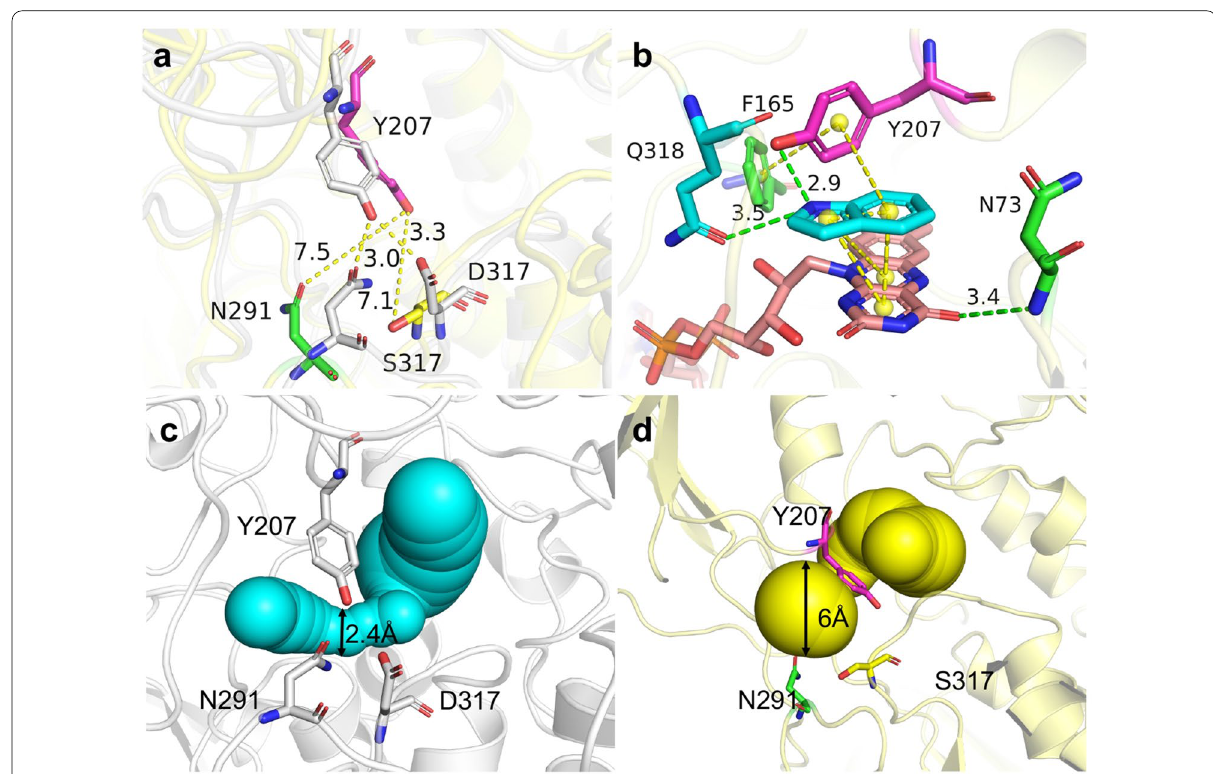
Fig. 8 Structure of K223R/D317S mutant. a Comparison of the distance of residue 207–291 and residue 207–317 in wild‑type bFMO (grey) and the K223R/D317S mutant (yellow), respectively. Residues are shown as gray sticks in wild‑type bFMO. However, the residue 207, 291 and 317 are shown as purple, green and yellow sticks in the K223R/D317S mutant, respectively. b π–π interaction of Y207 (purple), indole (blue) and FAD (orange), and the π–π interaction between residues F165 and Y207 are shown in yellow dashed lines. The new hydrogen bond generated (green) between Y207 (purple) and Q318 (blue) to the indole (blue), respectively. The substrate tunnel shown in balls of wild‑type bFMO ( c ) and the K223R/D317S mutant ( d ) was identified by CAVER